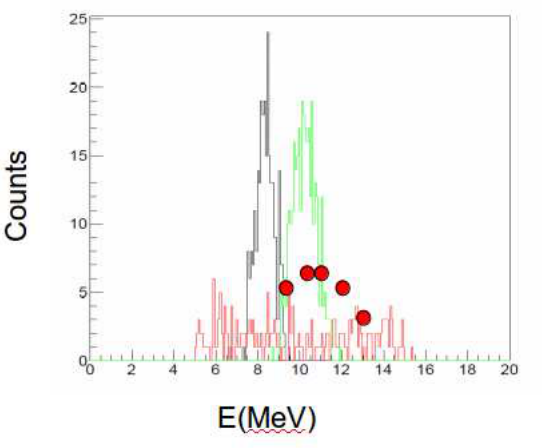
Figure 5. Simulated energy spectra for 3 He reaction products of the reaction 7 Be + 208 Pb at 22.5 MeV. The peaks with the black and green lines correspond to events due to elastic breakup and 4 He transfer, respectively. The red line correspond to non elastic breakup. The red spots correspond to our experimental energy spectra.